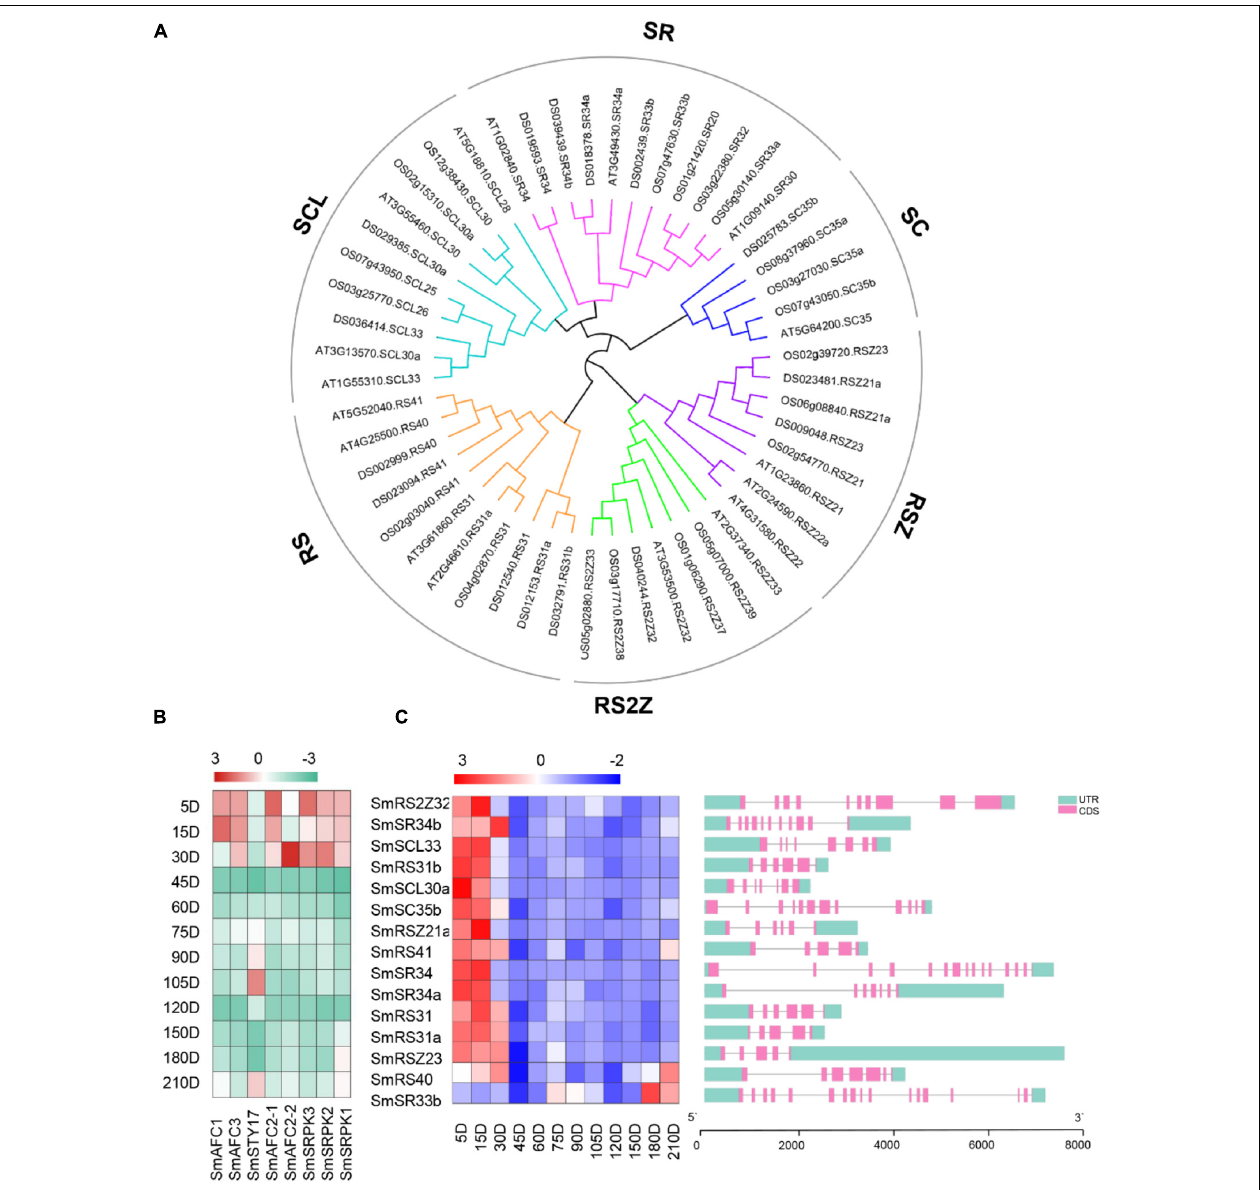
FIGURE 5 | Identification of SR proteins and phosphokinases in S. miltiorrhiza genome. (A) Phylogenetic analysis of SR proteins from Arabidopsis , rice, and S. miltiorrhiza using the complete protein sequences. Alignments of 52 SR proteins from A. thaliana , rice, and S. miltiorrhiza were performed and the Neighbor-joining tree was constructed using MEGA 7.0 software. (B) The transcript levels of eight PKs. (C) The transcript levels of SR proteins coding genes and gene structure analyses were performed by TB tools software. The green boxes, pink boxes, and black lines indicate upstream/downstream UTR, exons, and introns,